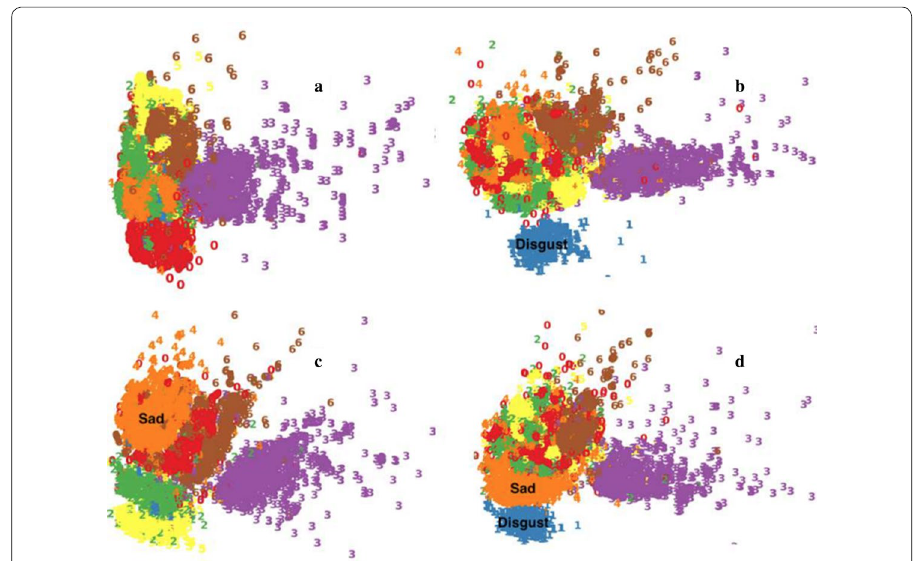
Fig. 21 t-SNE visualization demonstrating the improved decision boundaries when using CycleGAN-generated samples. a original CNN model, b adding GAN-generated disgust images, c adding GAN-generated sad images, d adding both GAN-generated disgust and sad images [93]